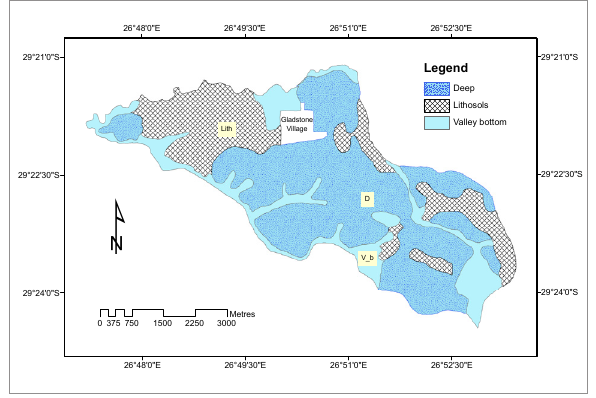
Figure 2: Map showing the distribution of the three soil associations considered: deep soils, lithosols and valley-bottom soils.